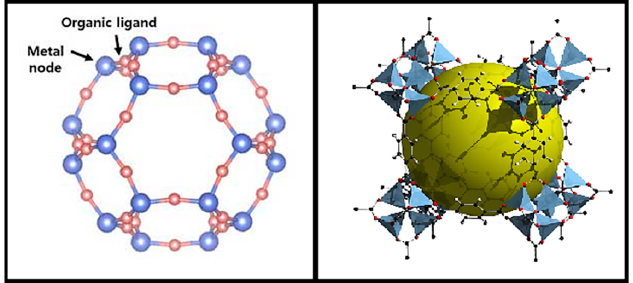
Figure 10. Schematic diagram of a metal-organic framework (MOF). The MOF, consisting of metal ions and organic ligands, is a highly porous material with an ultra-high surface area.